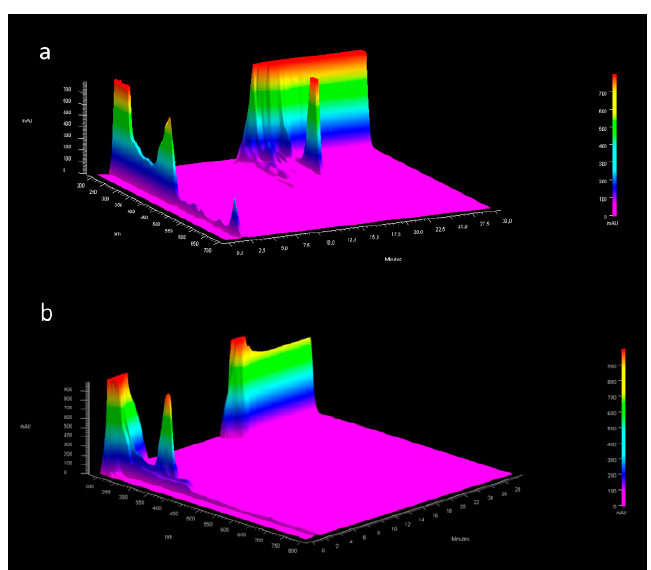
Figure 2. 3D image of chromatographic elution of a ( a ) Methanol extract and ( b ) Ethanol extract from 0 to 30 min.